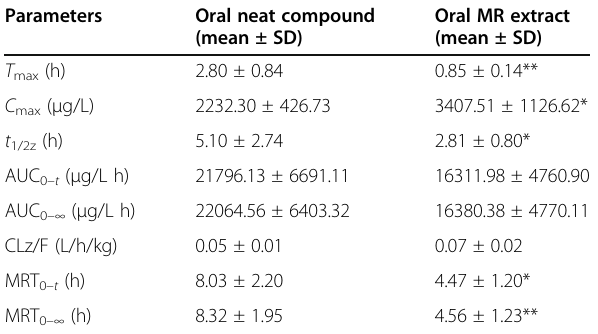
single-dose administration ( n = 6)